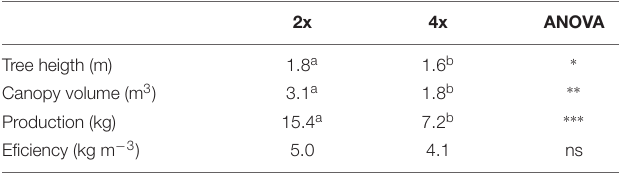
Values are means of 12 plants (n = 12). Significant differences for ploidy (P) tested by ANOVA are indicated as follows: ∗ P < 0.05; ∗∗ P < 0.01; ∗∗∗ P < 0.001; ns,